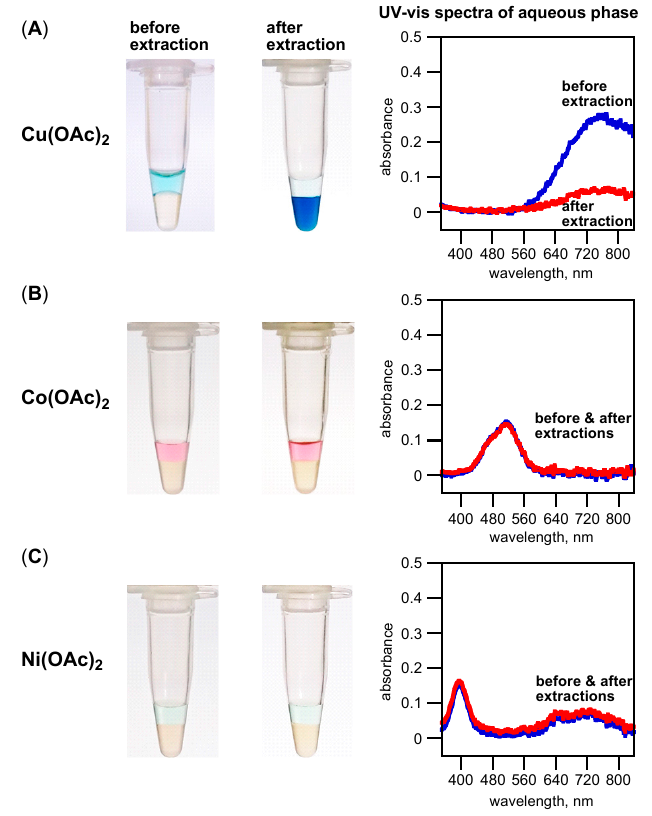
Figure 2. Optical photographic images and UV-vis spectra of chemoselective extractions of ( A ) Cu(OAc) 2 Figure 2. (0.1 M); ( B ) Co(OAc) 2 (0.25 M) and ( C ) Ni(OAc) 2 (0.25 M) in H 2 O (25 μ L each) by AIL 3 (0.25 M) in ( A ) Cu(OAc) 2 (0.1 M); ( B ) Co(OAc) 2 (0.25 M) and ( C ) Ni(OAc) 2 (0.25 M) in H 2 O (25 µ L each) by ionic liquid 2 (25 μ L), respectively. UV-vis spectra (1 mm path length) of aqueous layers were AIL 3 (0.25 M) in ionic liquid 2 (25 µ L), respectively. UV-vis spectra (1 mm path length) of obtained by a NanoDrop 2000 spectrophotometer (Thermo Scientific, Waltham, MA, USA).